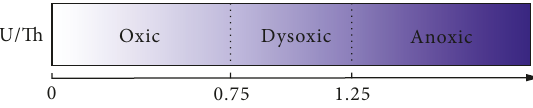
Figure 3: The correlation chart for U/Th identi fi ed as reliable indices of depositional conditions. The chart is modi fi ed from Jones and Manning [35]. See Figure 1 for the well